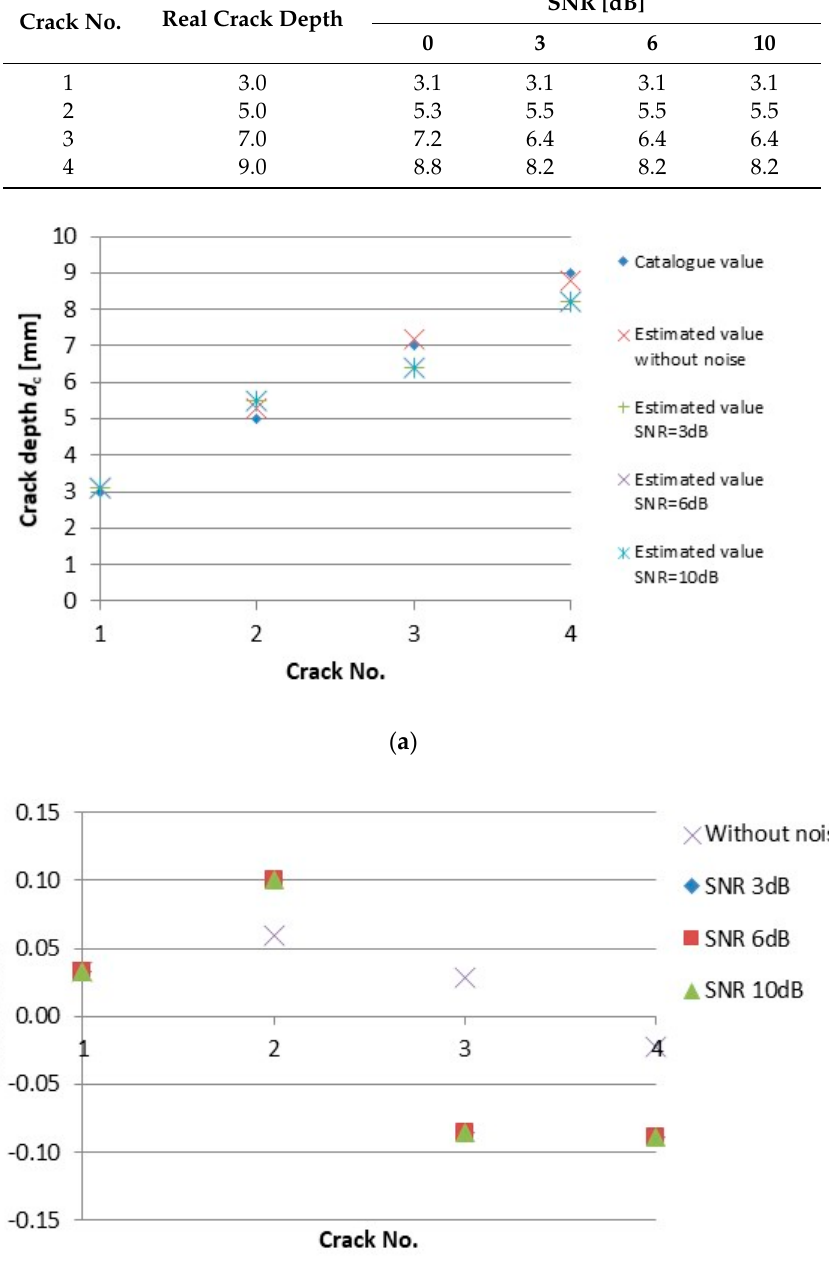
Table 3. Values of the reconstructed crack depth d c from the ECT responses with di ff erent SNR. Crack No.